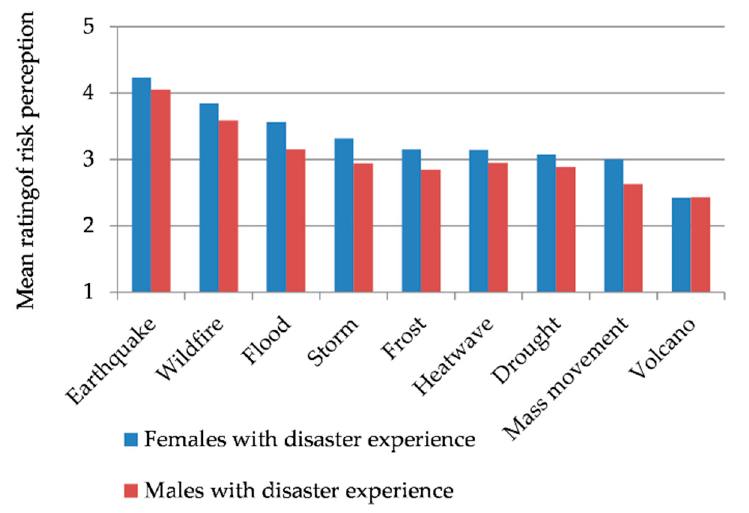
Figure 12. Average risk perception by gender and hazard, among respondents with disaster experience.